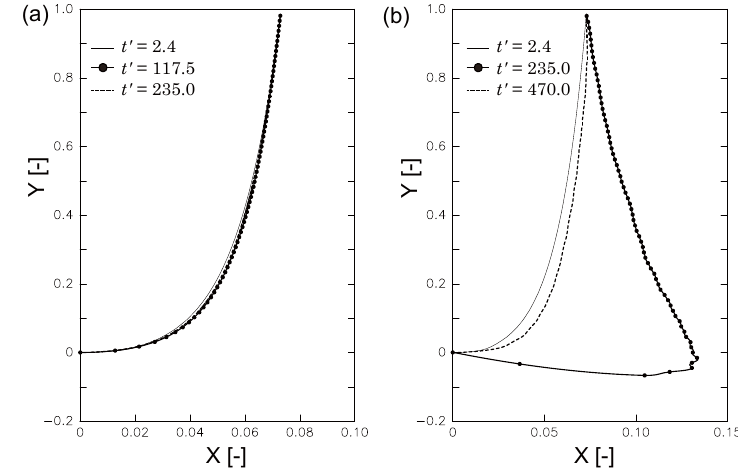
Figure 8. Distributions of the ( a ) dynamic tension and ( b ) dynamic curvature for one bucket. t (cid:48) denotes dimensionless time.